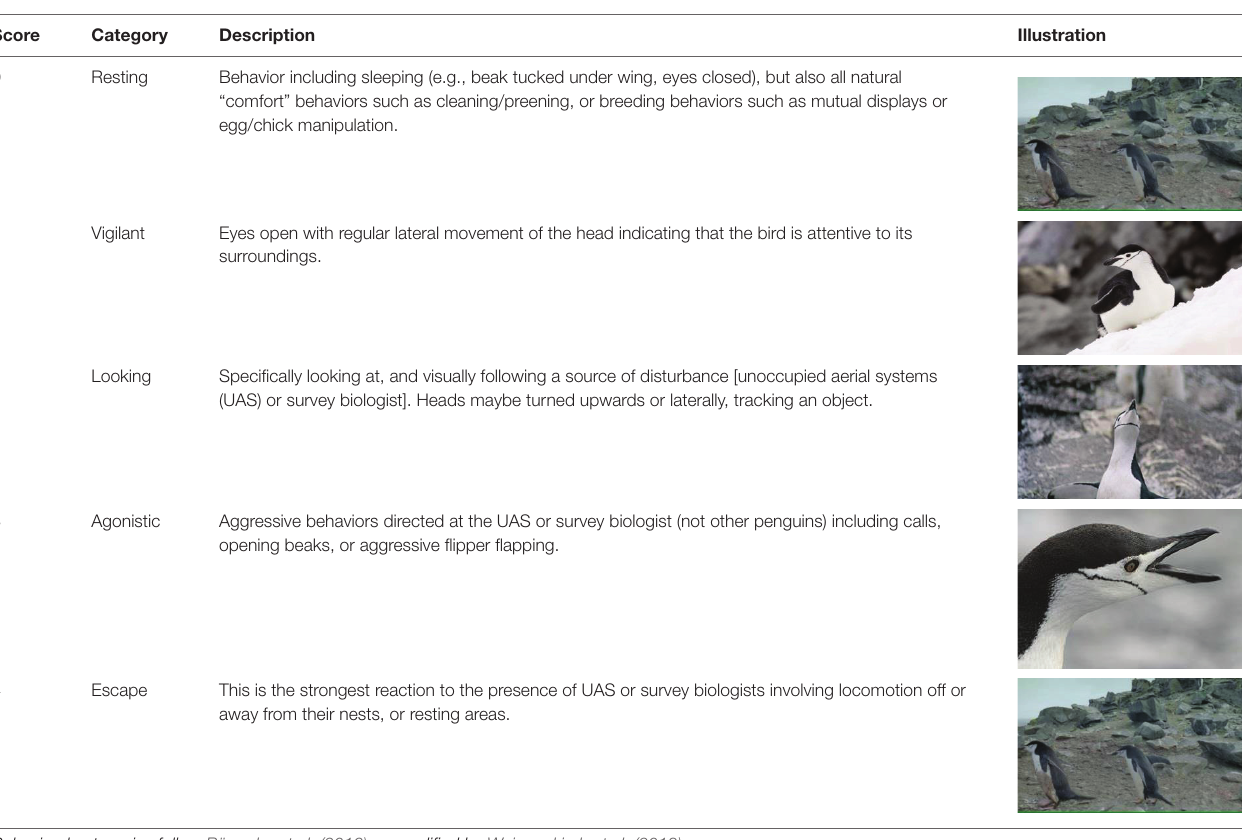
TABLE 2 | Ethogram describing the five levels of behavioral response scores ( n = 4,809) assigned by independent observers based on photographs of chinstrap penguins.